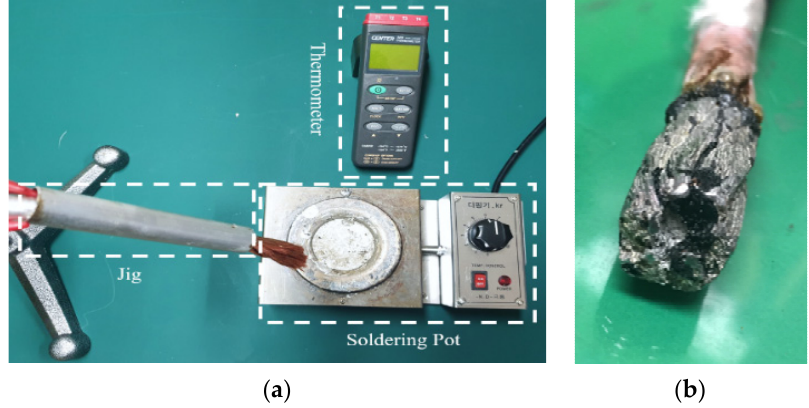
Figure 4. ( a ) Soldering set. ( b ) Solder failure (solder pot temperature 500).